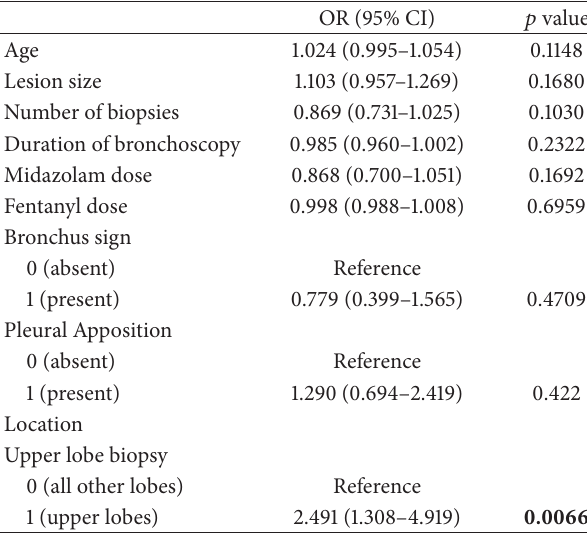
Table 5: Univariable logistic regression in predicting complications of